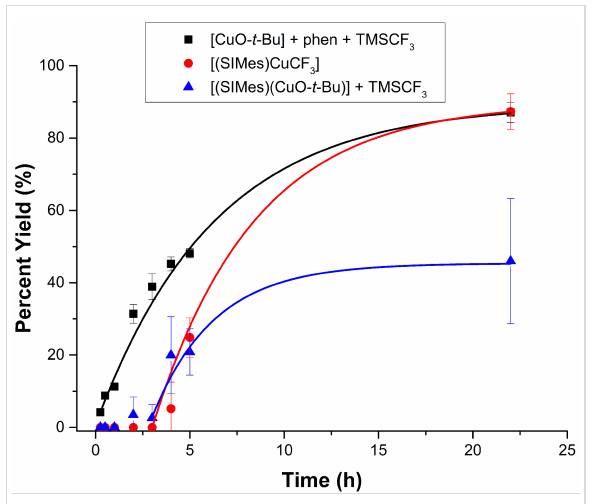
Figure 3: Reaction of 1-iodo-4-methylbenzene with systems A1 , A2 , and B2 to produce 1-methyl-4-(trifluoromethyl)benzene. Conditions for B2 : DMF, 50 °C. Conditions for A1 and A2 : DMI/benzene (1.5:7.5), 50 °C. Yields were calculated by 19 F NMR spectroscopy versus an internal standard.